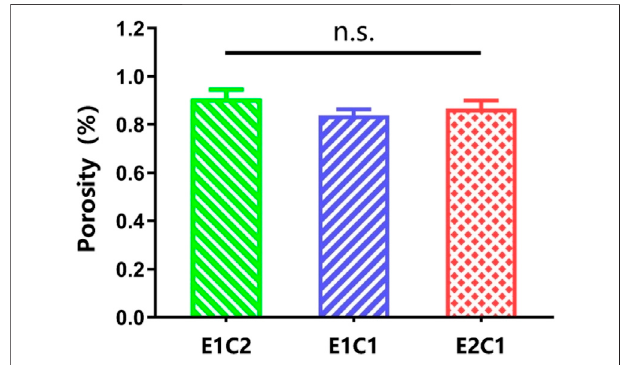
FIGURE 6 | The porosity of the scaffolds. n.s.: p >